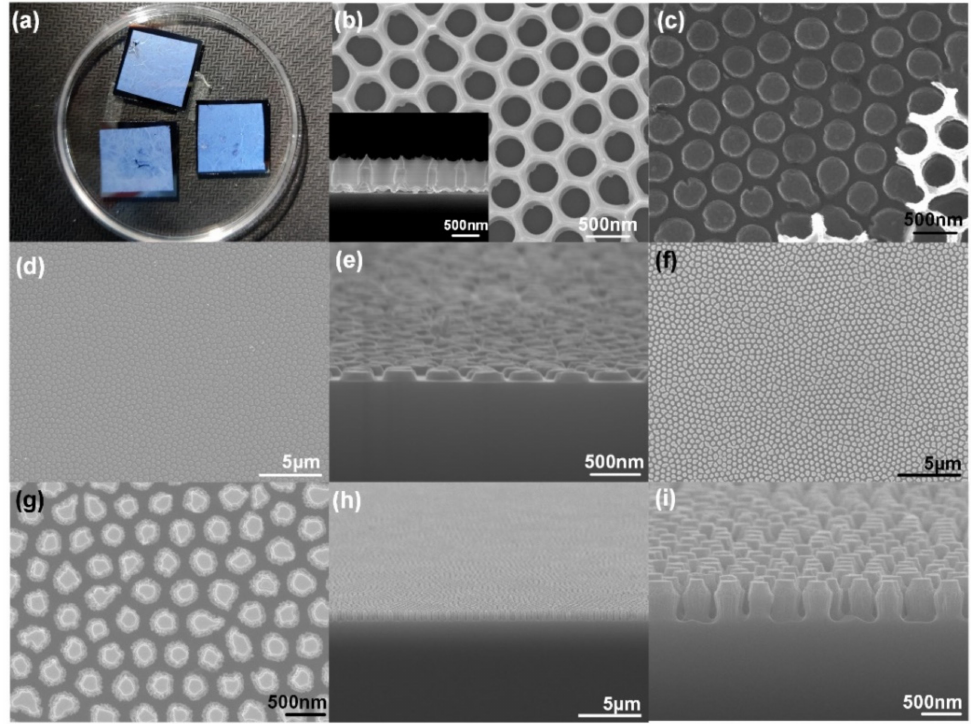
Figure 2. The main surface morphologies during the experiments: ( a ) Photography picture of the transferred through-hole AAO thin film on Si, the size of the silicon is 18 mm × 18 mm. SEM images for ( b ) top view of through-hole AAO thin film on Si (the picture of lower left corner is the side view of through-hole AAO thin film on Si), ( c ) after aluminum evaporation, ( d ) aluminum nano-arrays after the removal of AAO, ( e ) oblique view of the aluminum nano-arrays, ( f , g ) top view of the final Si nanostructure after the removal of aluminum, ( h , i ) oblique view of the nano-arrays of the final Si